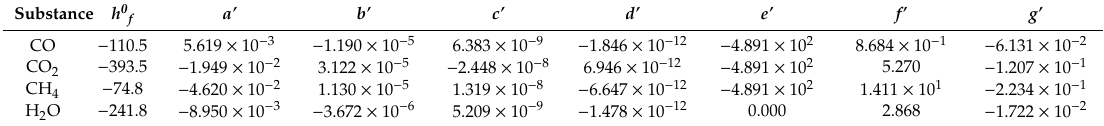
Table 3. Enthalpy of formation (kJ / mol) and coe ffi cients of the Gibbs equation (kJ / mol)